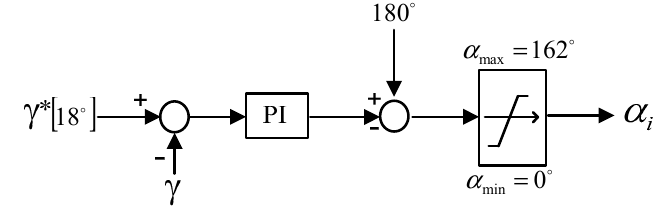
Figure 6. Extinction angle control of LFAC. Figure 7. Gate block control scheme of LFAC.